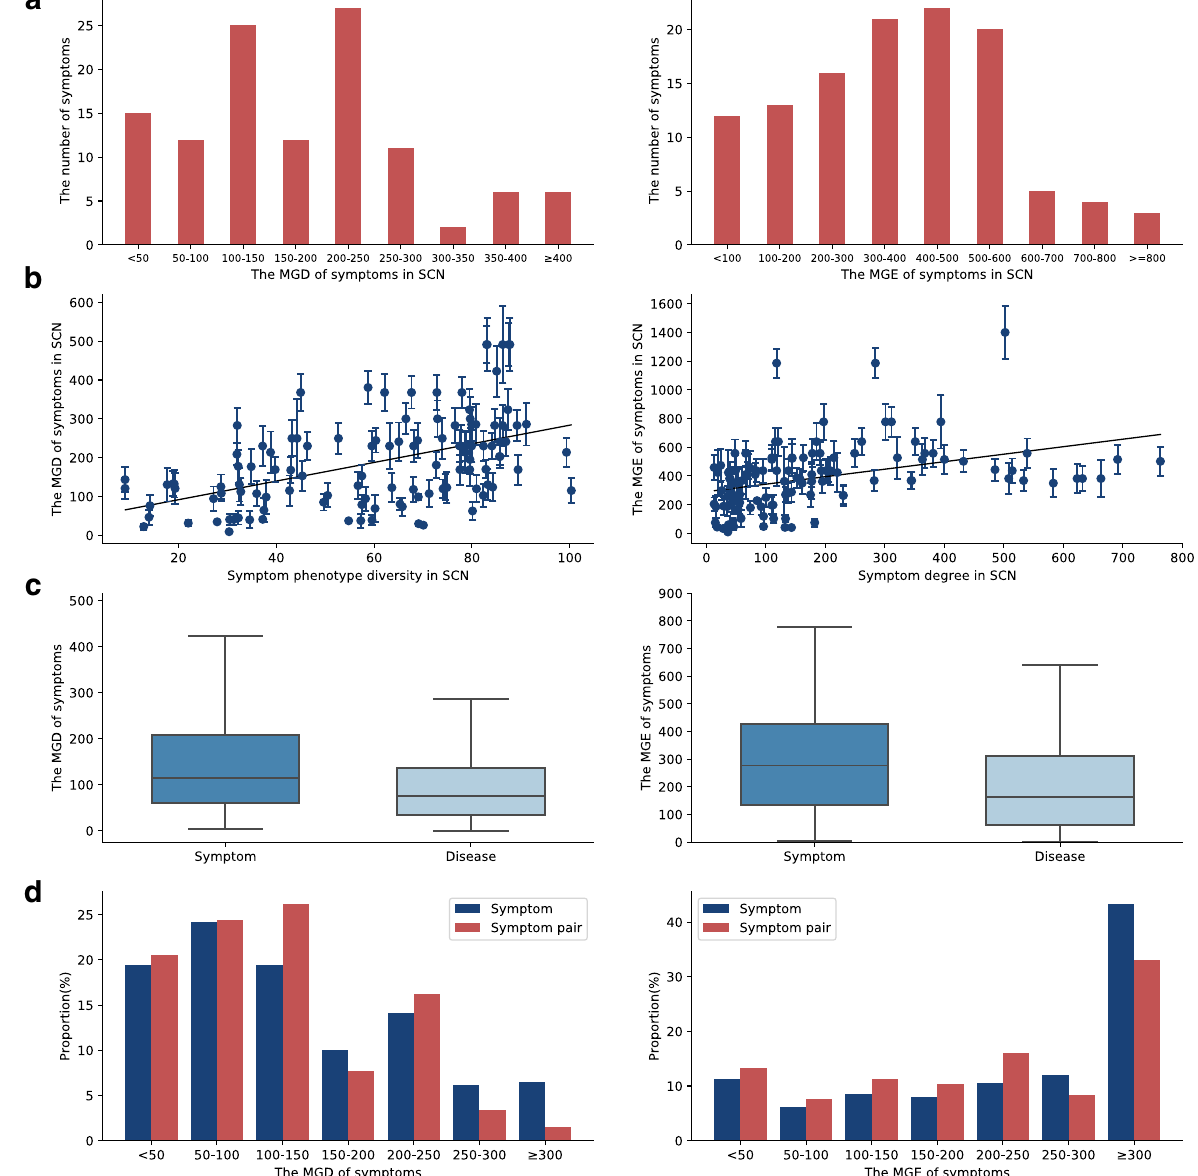
Fig. 4 Symptom network diversity analysis. a The MGD and MGE distribution of symptoms in SCN. b Correlations of the symptom diversity between phenotypic and molecular networks. c Compared the MGD and MGE distribution of symptoms and diseases. On each box, the central mark indicates the median, the bottom and top edges of the box indicate the 25th and 75th percentiles, respectively. The whiskers extend to the most extreme data represent the minimum and maximum value. d Compared the MGD and MGE distribution of symptoms and symptom